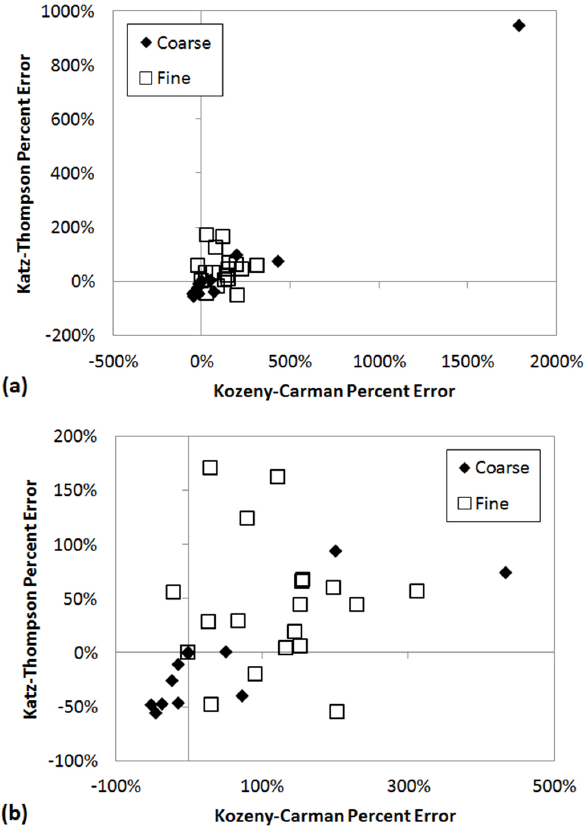
Fig. 6. (a) Percent error between approximated and measured per- meability for the Katz–Thompson and Kozeny–Carman approxima- tions. (b) Same as (a) with the outlier point (as described in text) removed.